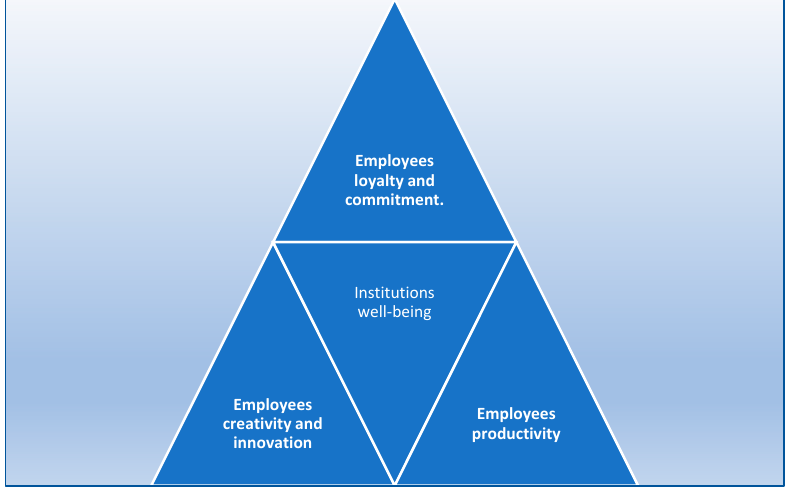
Figure 4. Institutional Well-being Dimensions. Figure created by the author.